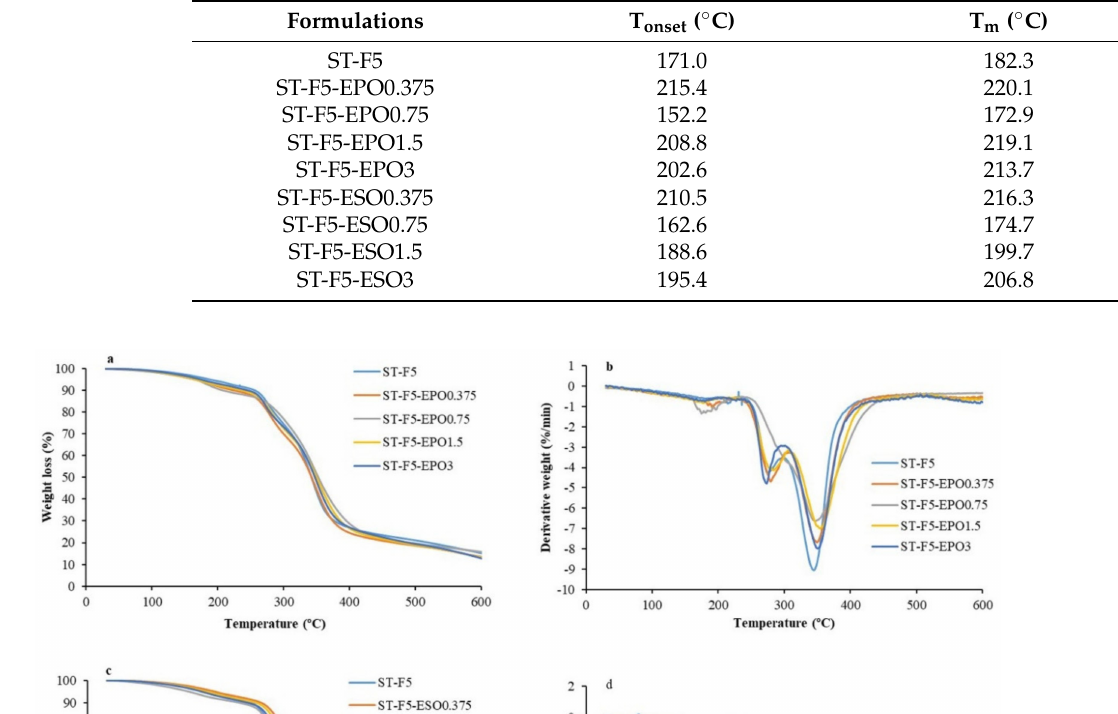
Figure 4. Diffraction scanning calorimetry (DSC) curves of all the bioplastic composites. Table 2. Melting temperature of the prepared bioplastic composites.